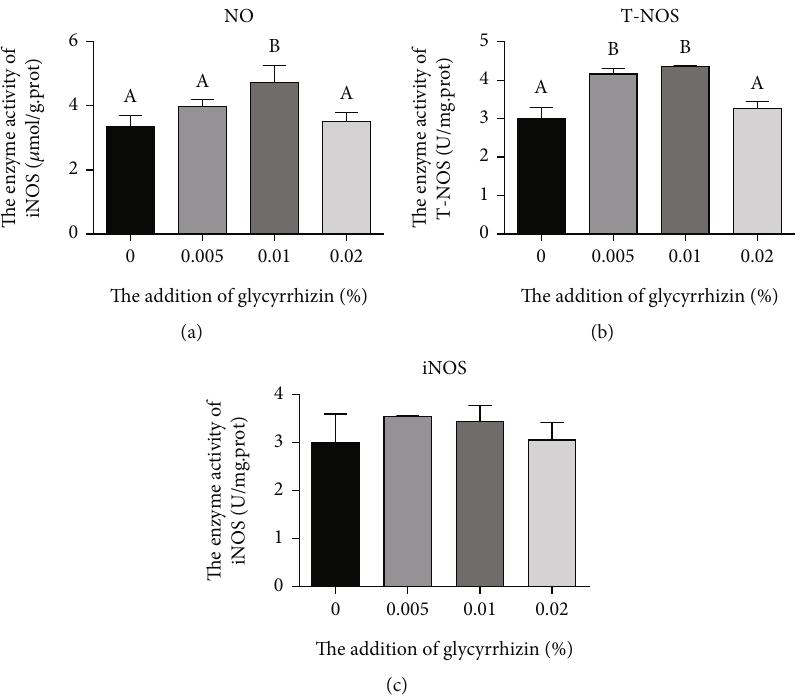
Figure 3: The content of NO and activities of T-NOS and iNOS in visceral mass of large yellow croaker larvae. (a) NO: nitric oxide; (b) T- NOS: total nitric oxide synthase; (c) iNOS: inducible nitric oxide synthase. Values are means ( n = 3 ), with their standard errors represented by vertical bars. Bars bearing the same or no letters were not signi fi cantly di ff erent determined by Tukey ’ s test ( P > 0 : 05 ).